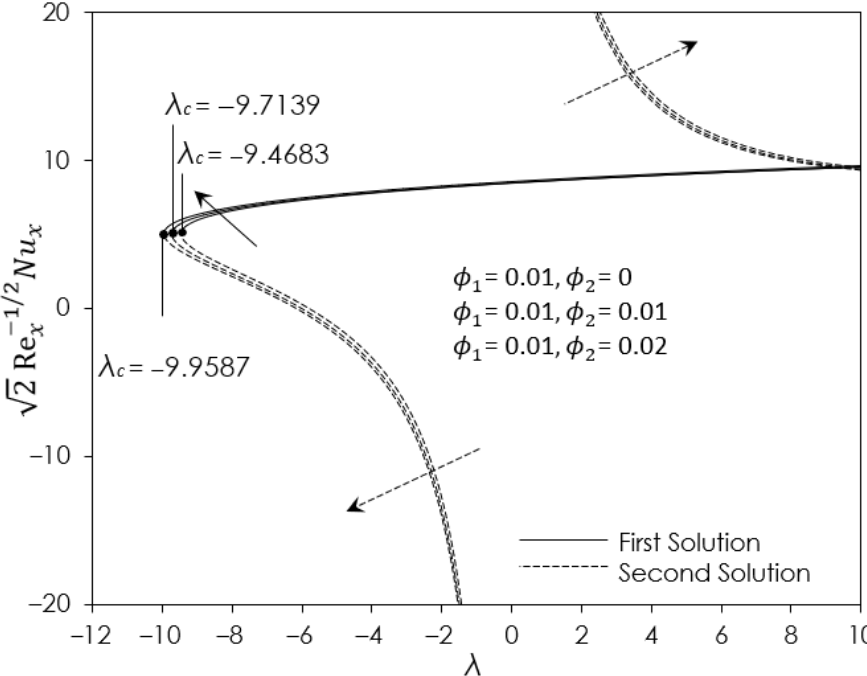
Figure 2. Variation of √2 Re 𝑥1/2 𝐶 𝑓 for different values of 𝜙 2 .